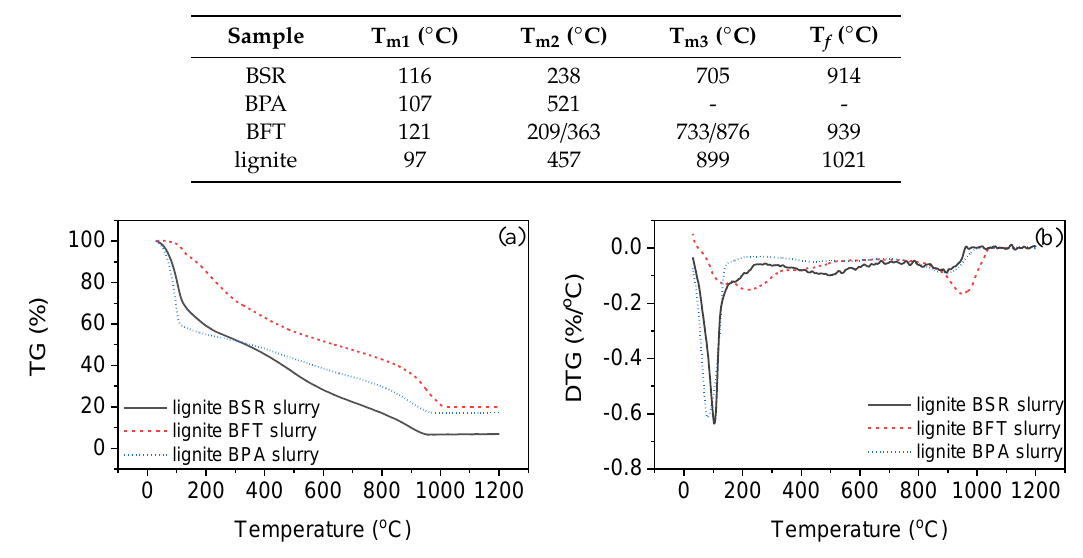
Table 3. Gasification performance indices of individual fuels.